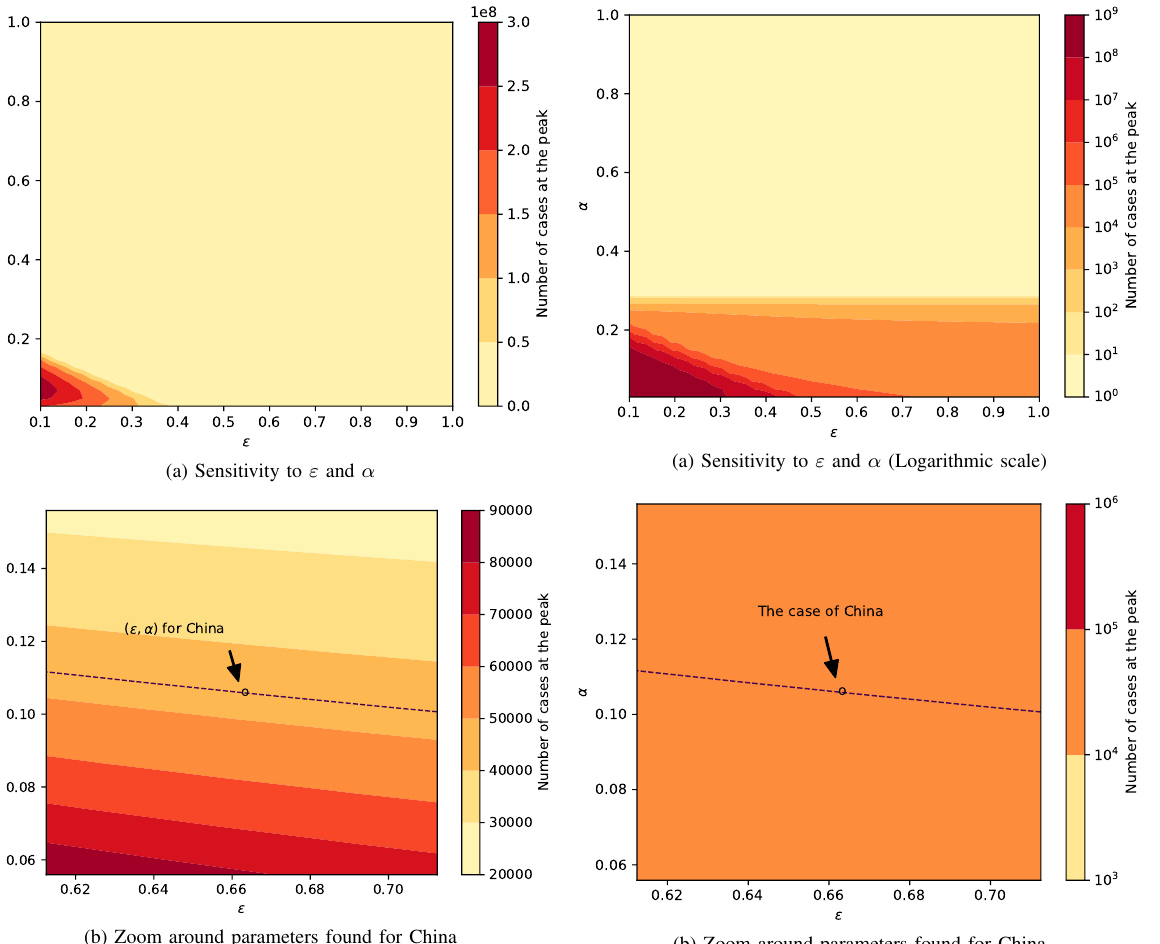
Fig. 6: Sensitivity of the number of active infected cases at the peak to the detection rate α and efficacy ε of protective measures.